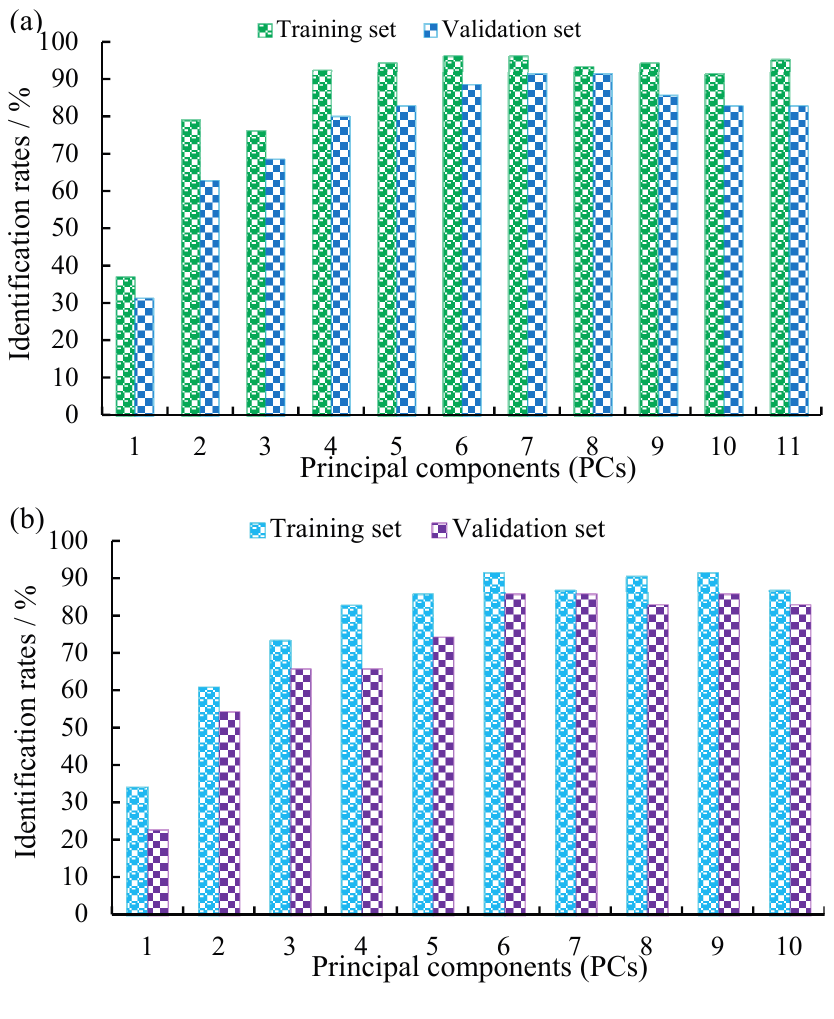
Figure 2. Identification rates of the identified model with a different number of PCs in training and validation sets. Results obtained from ( a ) electronic nose data and ( b ) NIRS